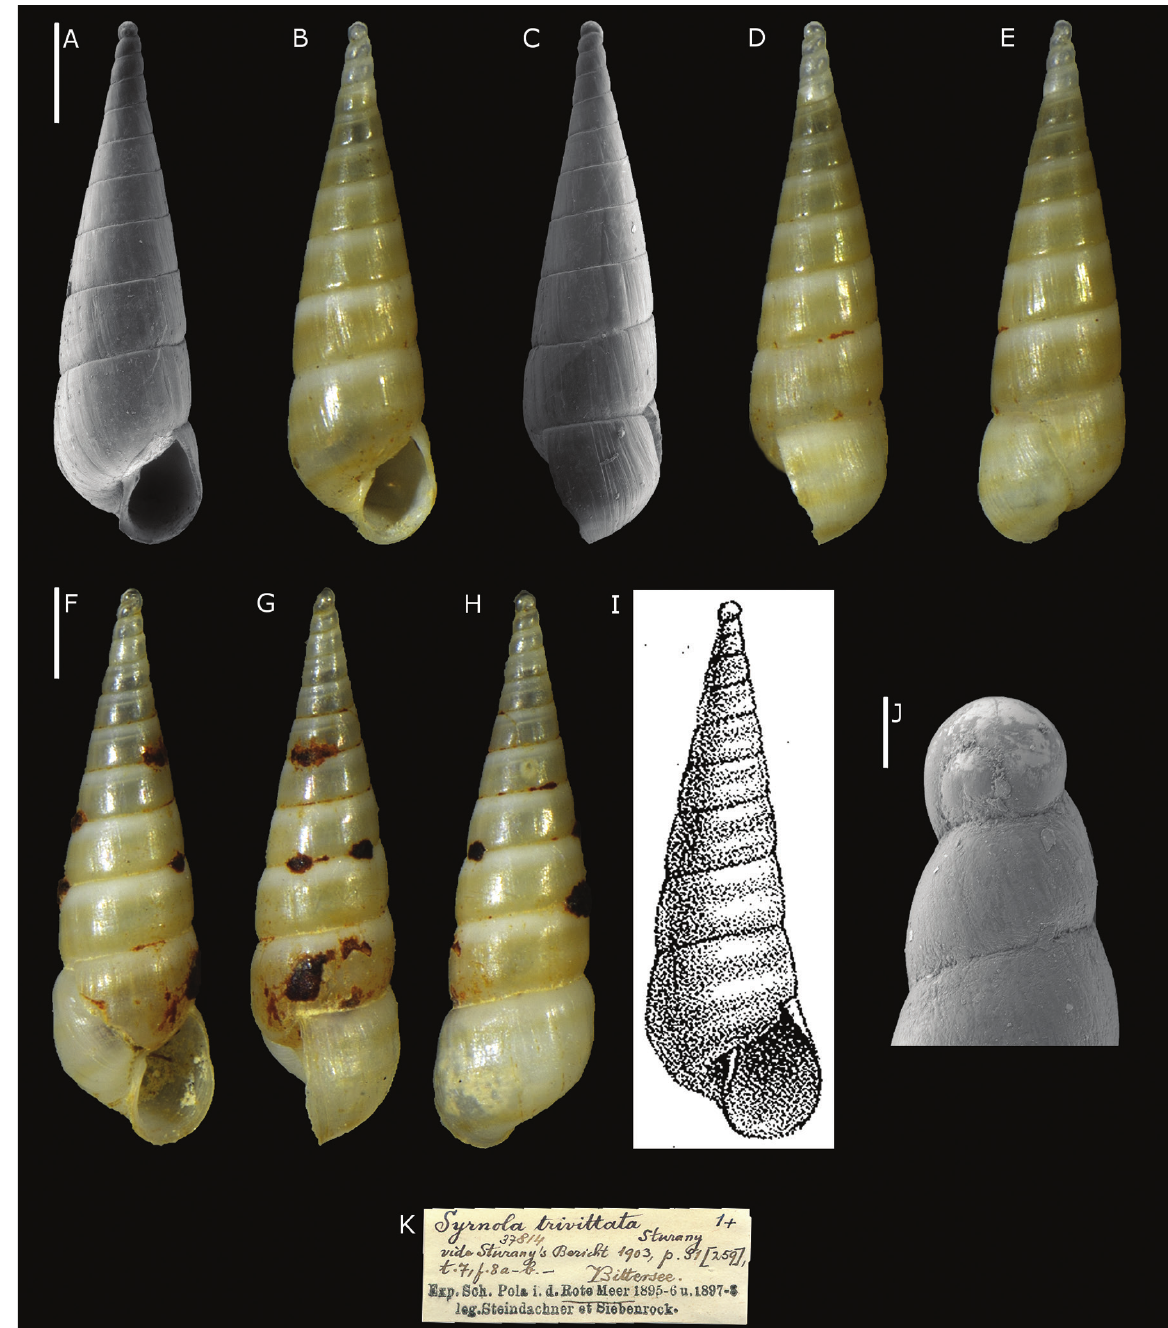
Figure 32. Syrnola trivittata Sturany, 1903 (Bitter Lakes, Suez Canal). A–E, J . Figured syntype, NHMW 37814: front ( A–B ), right side ( C–D ), back ( E ), protoconch ( J ). F–H . Syntype, NHMW 37814: front ( F ), right side ( G ), back ( H ). I . Original figure by Sturany (1903). K . Original label. Scale bars: A–H : 1 mm, J : 0.1 mm.